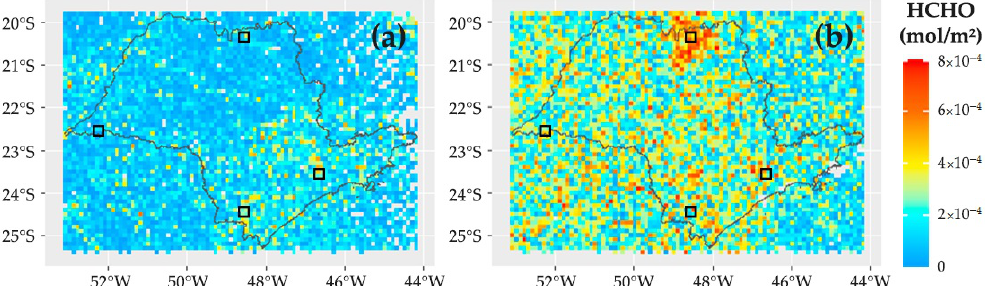
Figure 4. Satellite HCHO data (12 p.m.–4 p.m. local time) in São Paulo State: ( a ) 26 January 2020 (summer) and ( b ) 13 September 2020 (winter-spring). The black squares indicate the locations of the four areas of interest shown in Figure 2.